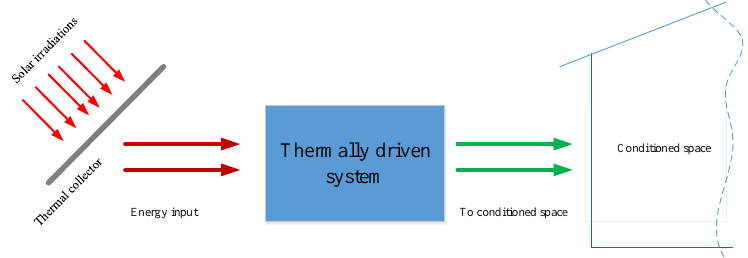
Figure 4. Basic concept of solar thermal air conditioning system.